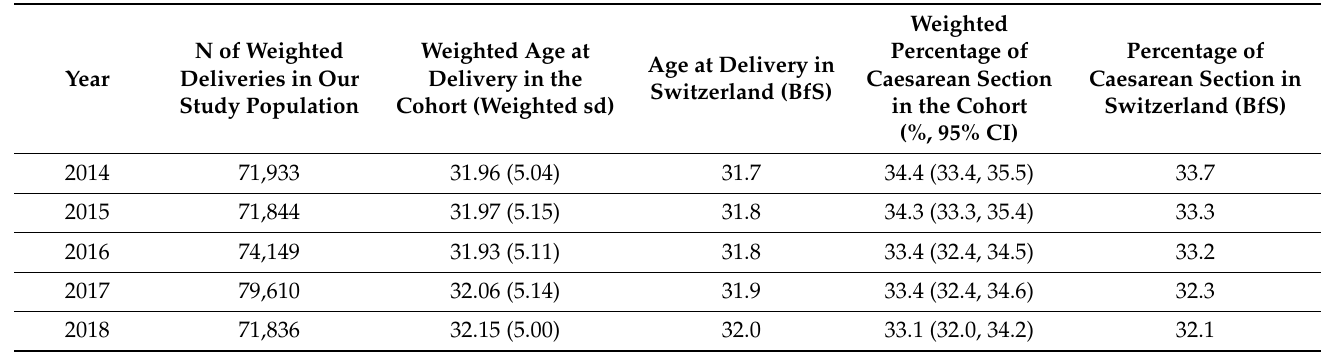
Table 1. Description of the weighted study population.